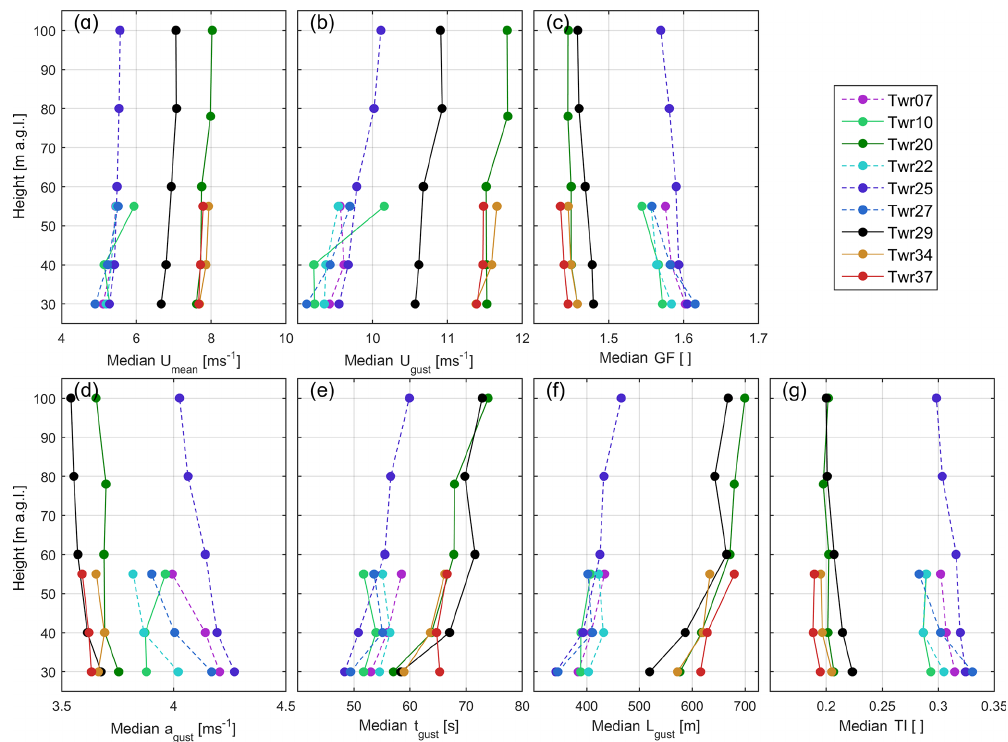
Figure 7. Median values of the gust parameters, by height, at each of the nine towers for 10min periods that meet the gust criteria: U mean > 3ms − 1 and a gust > 4ms − 1 . (a) The 10min mean wind speed ( U mean ), (b) 3s maximum wind speed ( U gust ), (c) gust amplitude ( a gust ), (d) gust factor (GF), (e) gust duration ( t gust ), (f) gust length scale ( L gust ), and (g) turbulence intensity